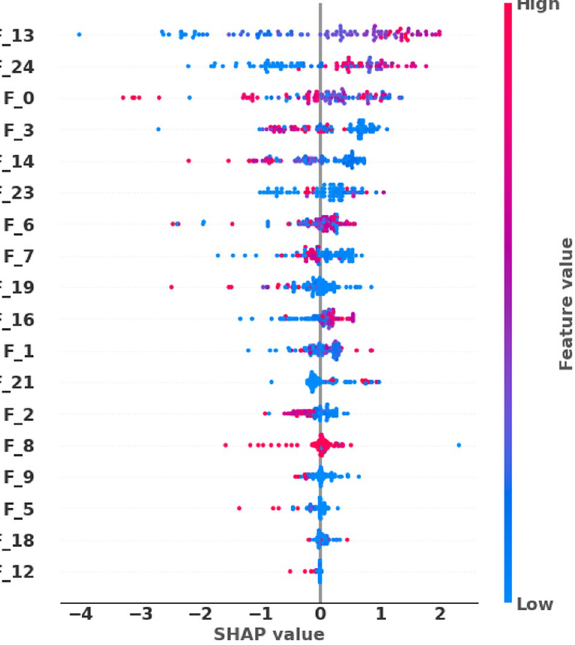
Fig. 6 XAI results using SHAP functions to the optimal reduct of fea- tures have the most influence on financial crisis prediction